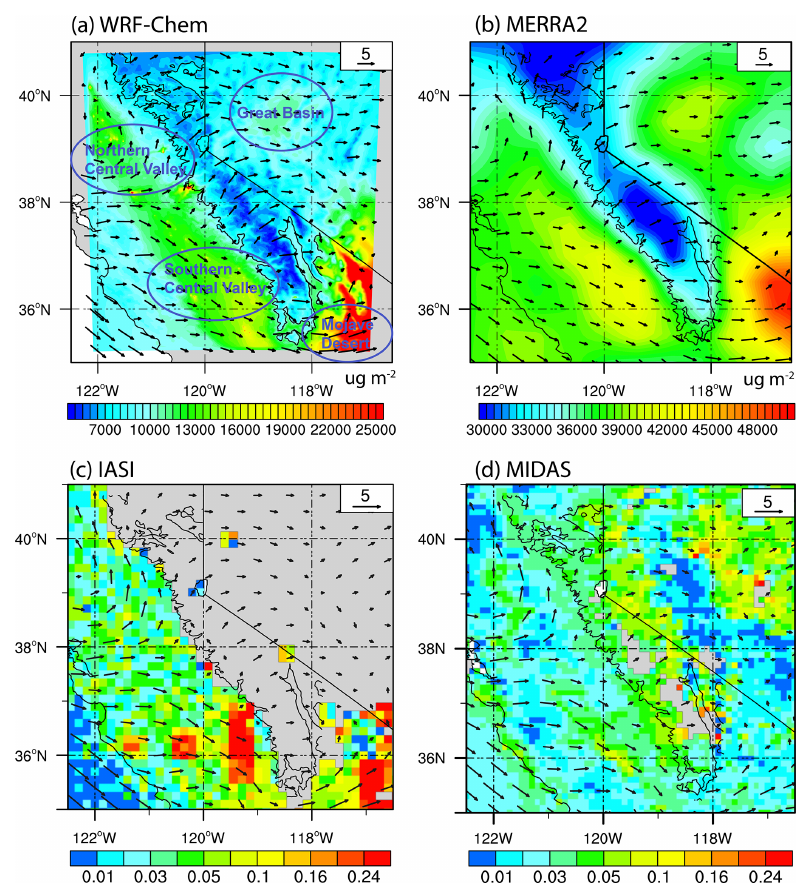
Figure 2. The spatial distribution of dust in model and satellite observations averaged in February–June 2019. Column dust loading (µm − 2 ) and low-level winds (roughly 875–925hPa; ms − 1 ) in (a) WRF-Chem and (b) MERRA-2. (c) Observed thermal infrared DOD at the wave- length of 10µm from IASI. (d) Observed visible DOD at the wavelength of 550µm from MIDAS. The low-level winds (ms − 1 ) in (c) and (d) are from ERA5 reanalyses. Black contours indicate an elevation of 1500m, which represents the Sierra Nevada range used in this study. The grey areas in (c) – (d) are missing pixels in satellite